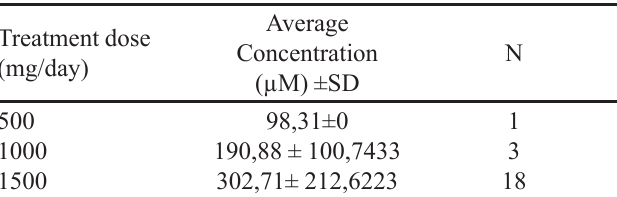
TABLE 2 - Average concentrations of HU in patients with SCA Treatment